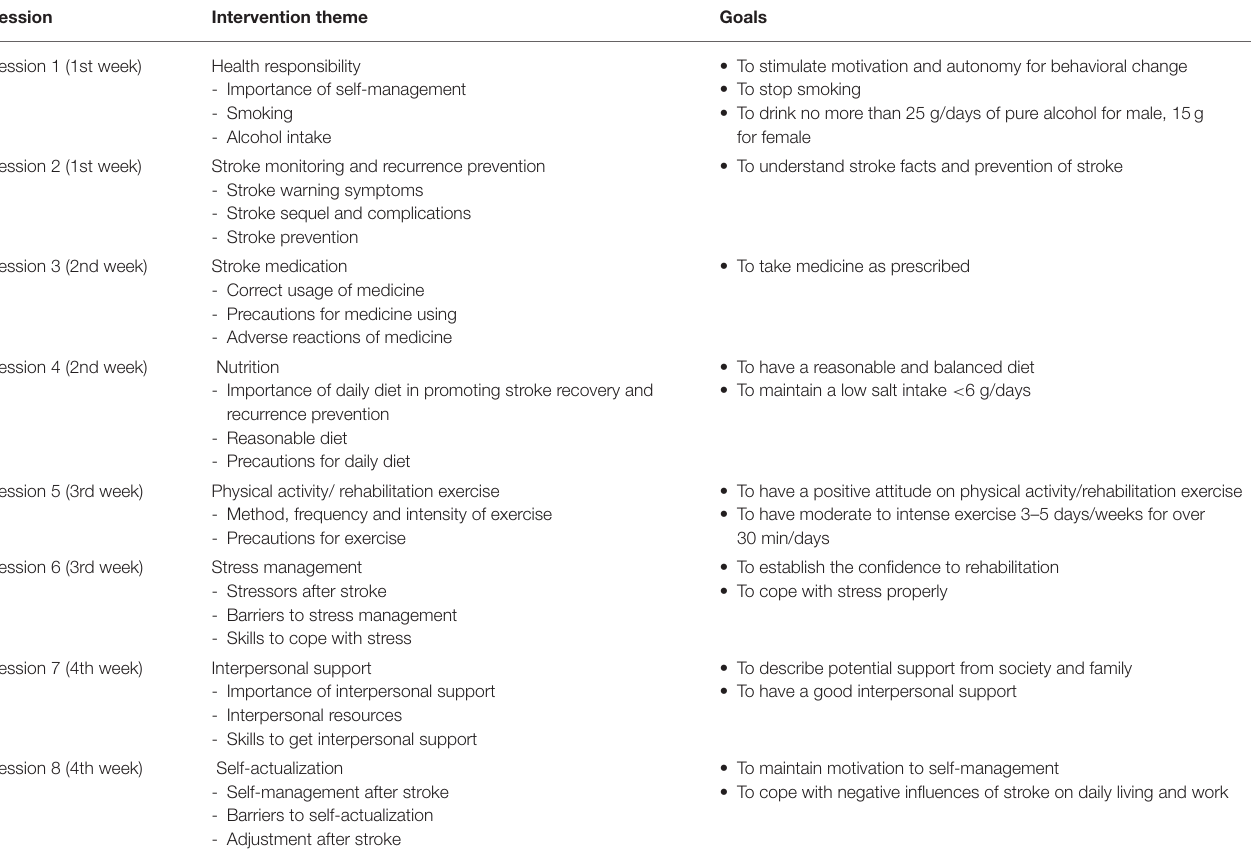
TABLE 1 | Contents and goals of the goal-oriented self-management intervention. Session